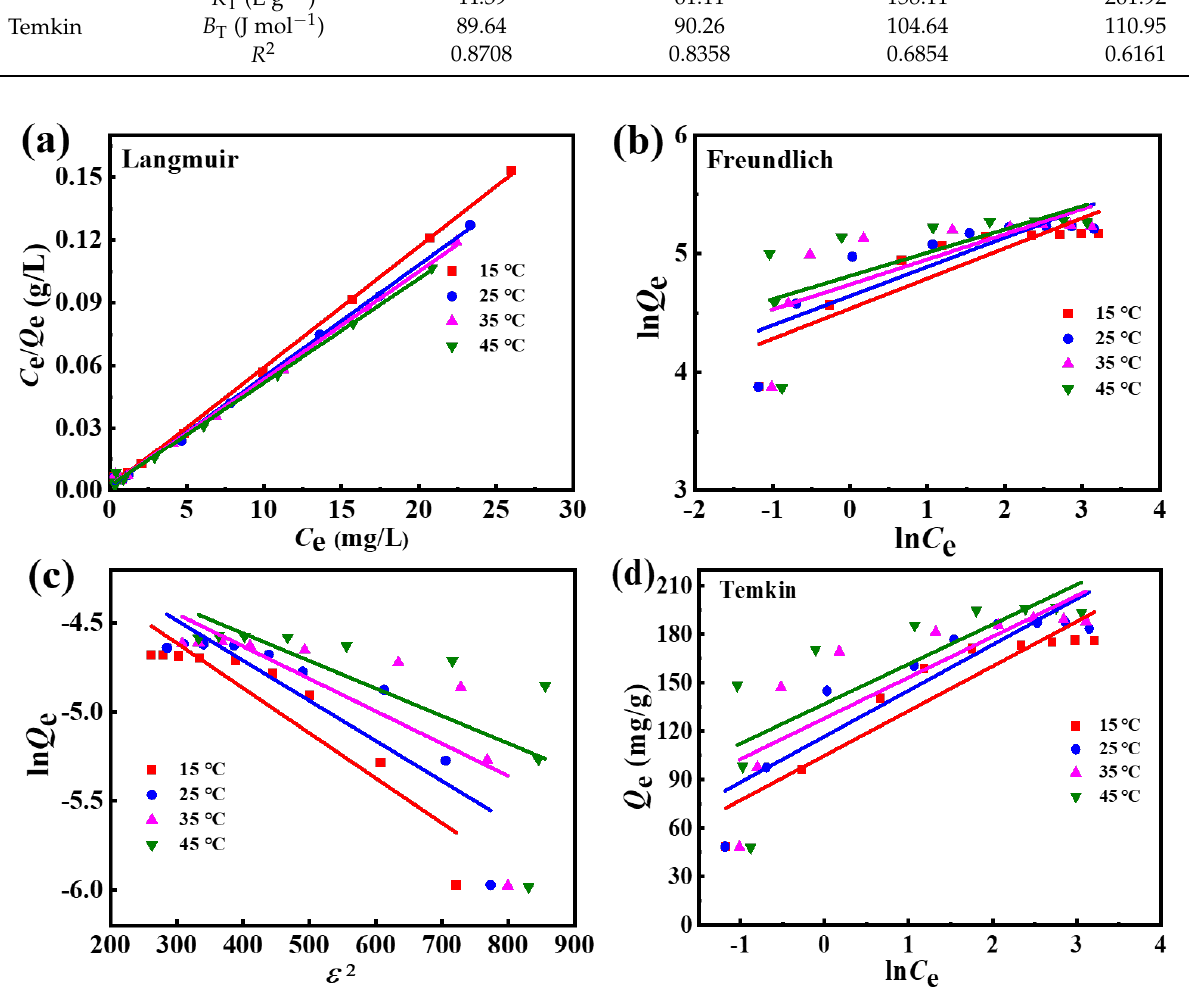
Figure 8. Adsorption isotherms of F − on LMF11 NFs, ( a ) Langmuir, ( b ) Freundlich, ( c ) D–R and ( d ) Temkin at 15–45 °C. Table 1. Four classical isotherms constants for defluoridation on LMF11 NFs at 15 to 45 °C.